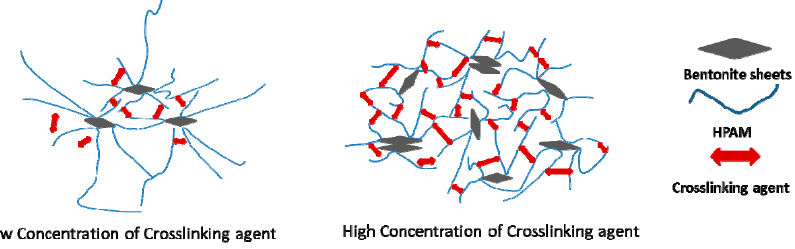
Figure 2. Particle-size distribution of composite gel under different crosslinker concentrations.